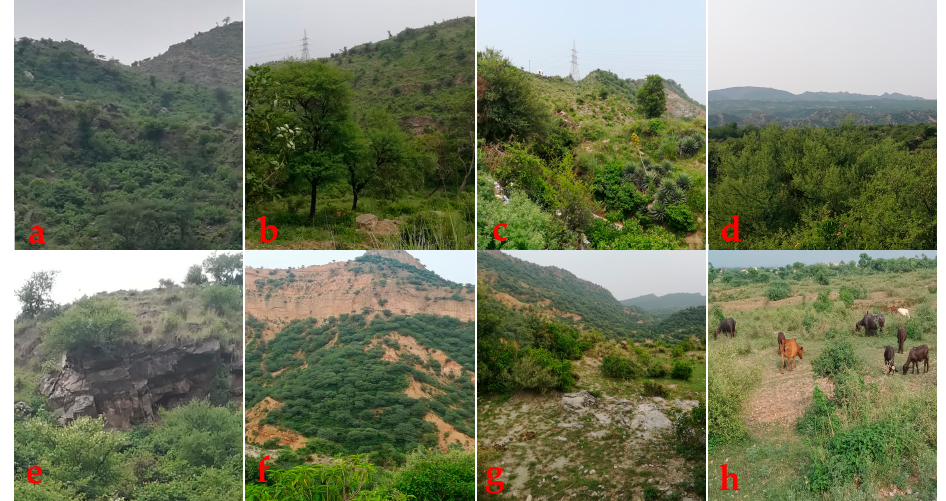
Figure 1. Diverse landscapes of Jhelum study area, NE Pakistan; ( a – d ): landscape depicting leading plant species associations (indicator species: Acacia modesta, Acacia nilotica, Prosopis juliflora, Ziziphus numularia, Justicia adhatoda and Dodonea viscosa ); ( e – g ): exposed sedimentary bedrock stratification (age: Pre-Cambrian to Pliocene; composition: limestone, sandstone, shale, and dolomite) and sandy loam textured soil; ( h ): rangeland for livestock grazing.